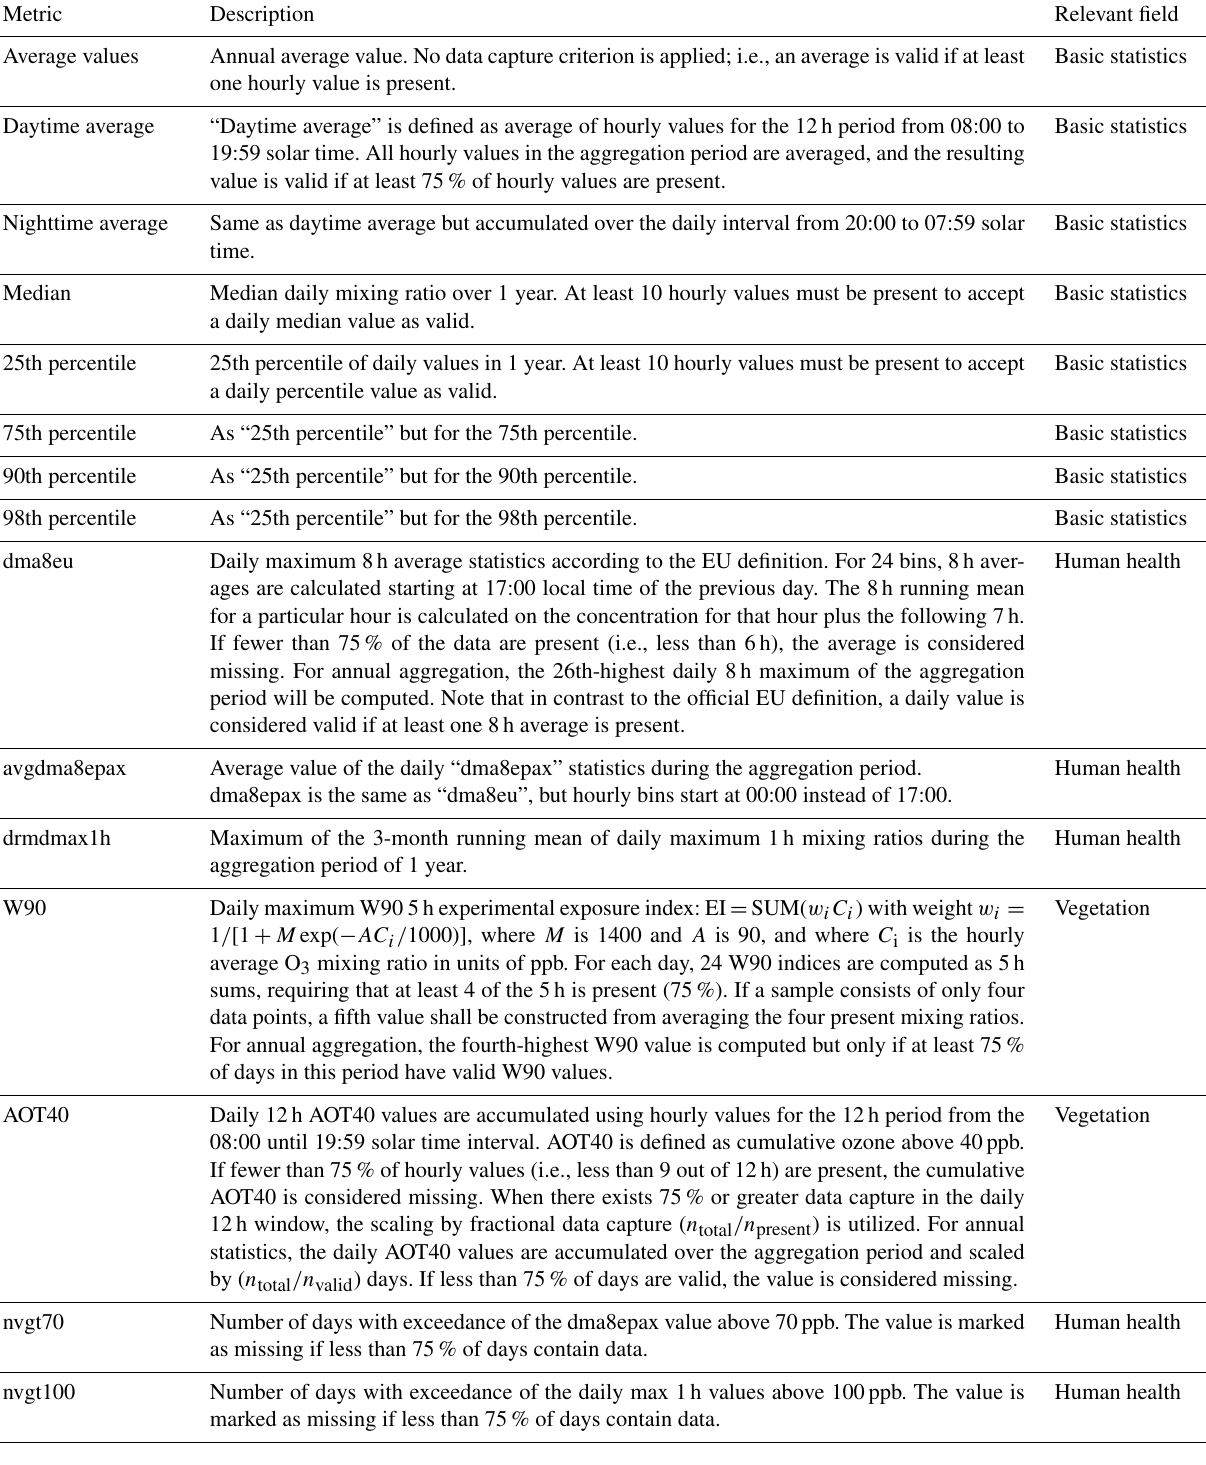
Table 2. The ozone metrics of AQ-Bench. The unit is ppb (parts per billion) for all metrics except the nvgt metrics, where it is the number of